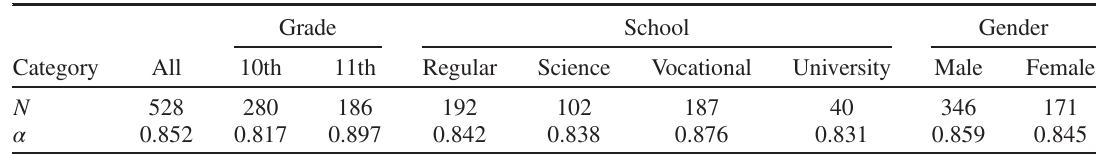
TABLE II. Cronbach α statistics for different populations of students who were administered the AAPS survey along with the number of students.